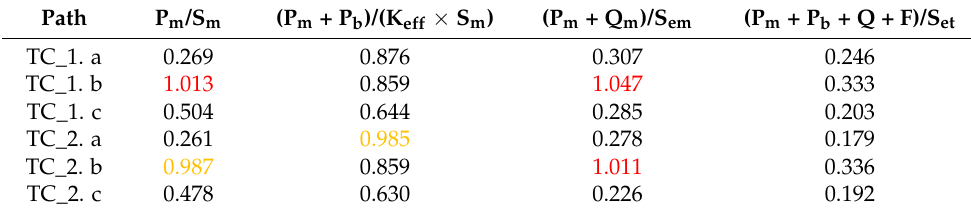
Table 1. RCC-MRx Level D criteria verification within TC domain.